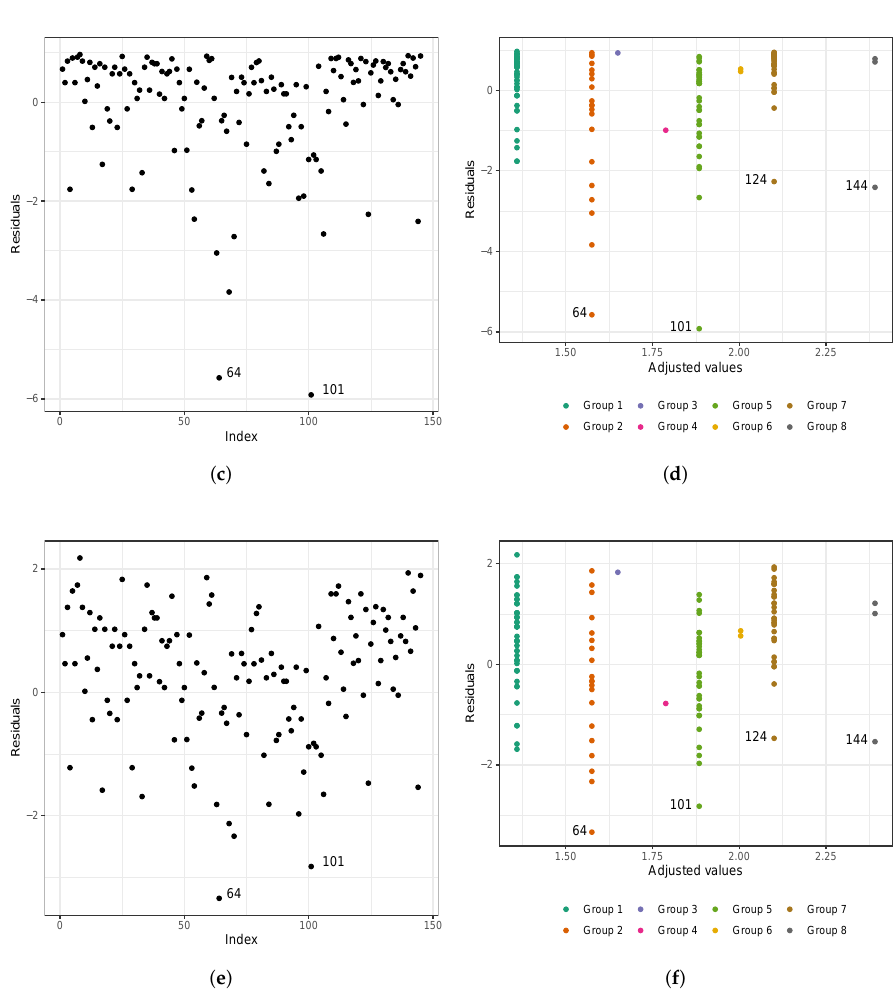
Figure 6. Plots of Cox–Snell ( a , b ), martingale ( c , d ), and deviance ( e , f ) residuals of the Weibull regression model adjusted to the data of length of stay in the surgery